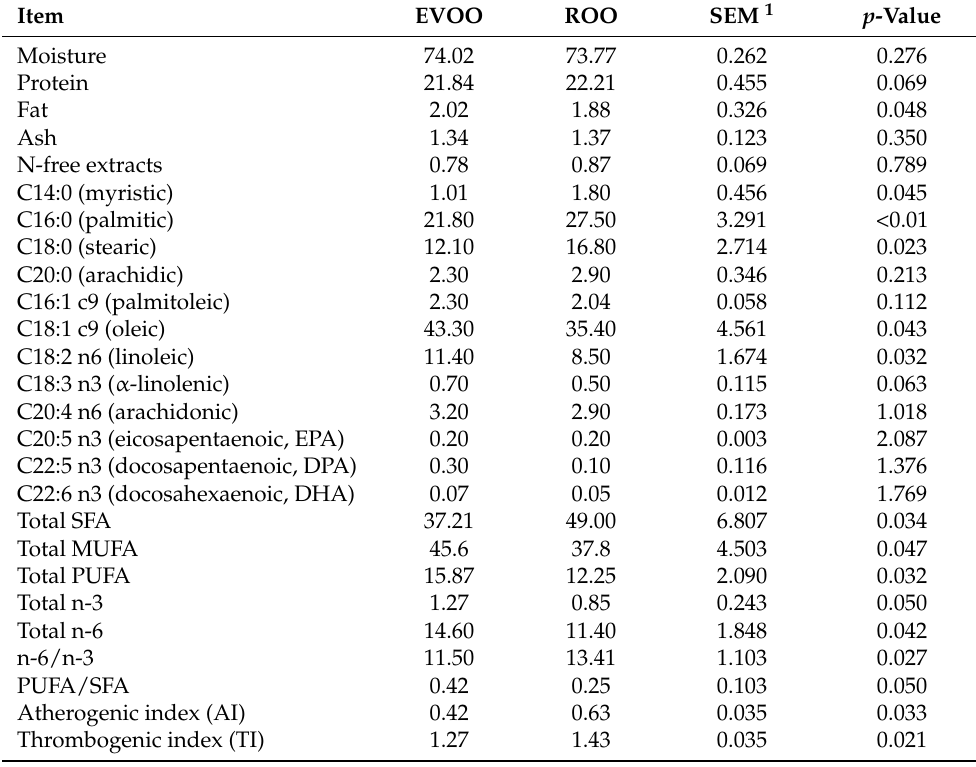
Table 3. Mean ( ± SE) chemical (%) and fatty acid (FA) composition (% of total FA methyl esters) of meat from the longissimus lumborum muscle of pigs fed a diet containing extra virgin (EVOO) or refined olive oil (ROO). Item